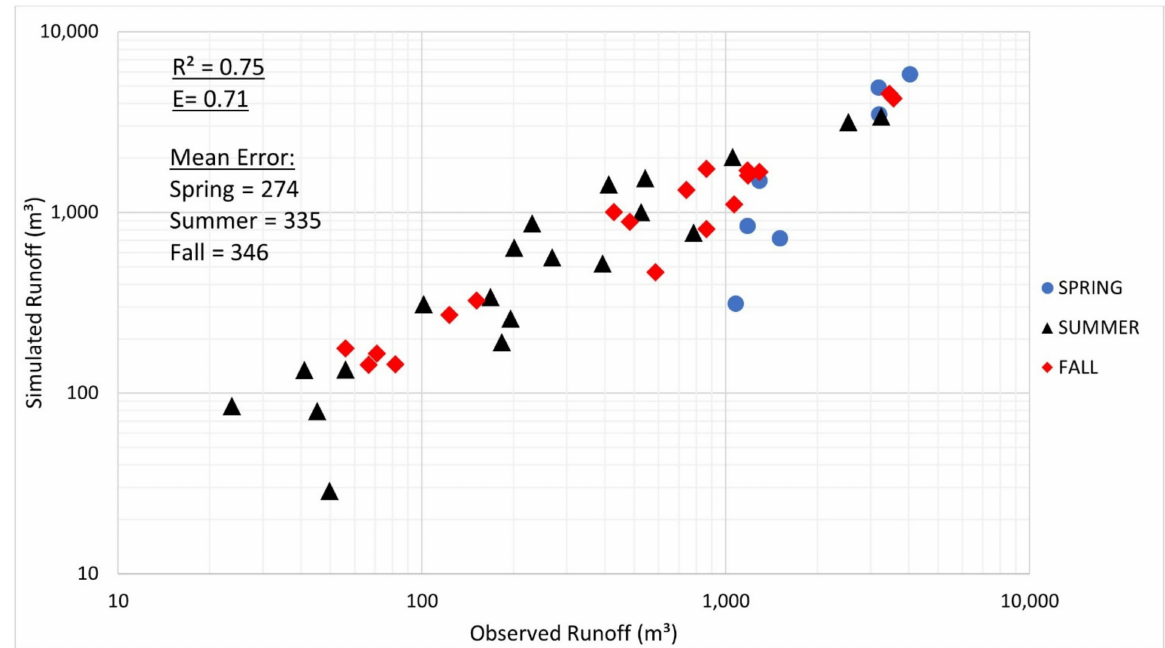
Figure 10. Comparison of the surface runoff simulated by the modified distributed CN–VSA method with the observed runoff for three